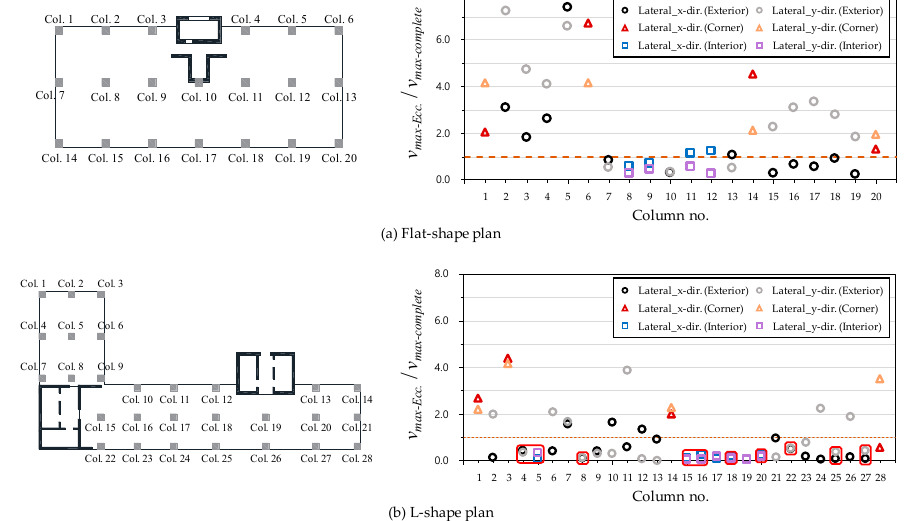
Figure 13. Maximum punching shear ratio according to the modeling method (for lateral load only). ( a ) Flat-shape plan and ( b ) L-shape